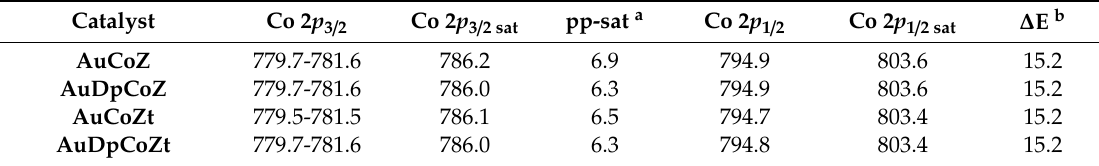
Table 2. X-ray photoelectron spectroscopy results for catalysts (all values in